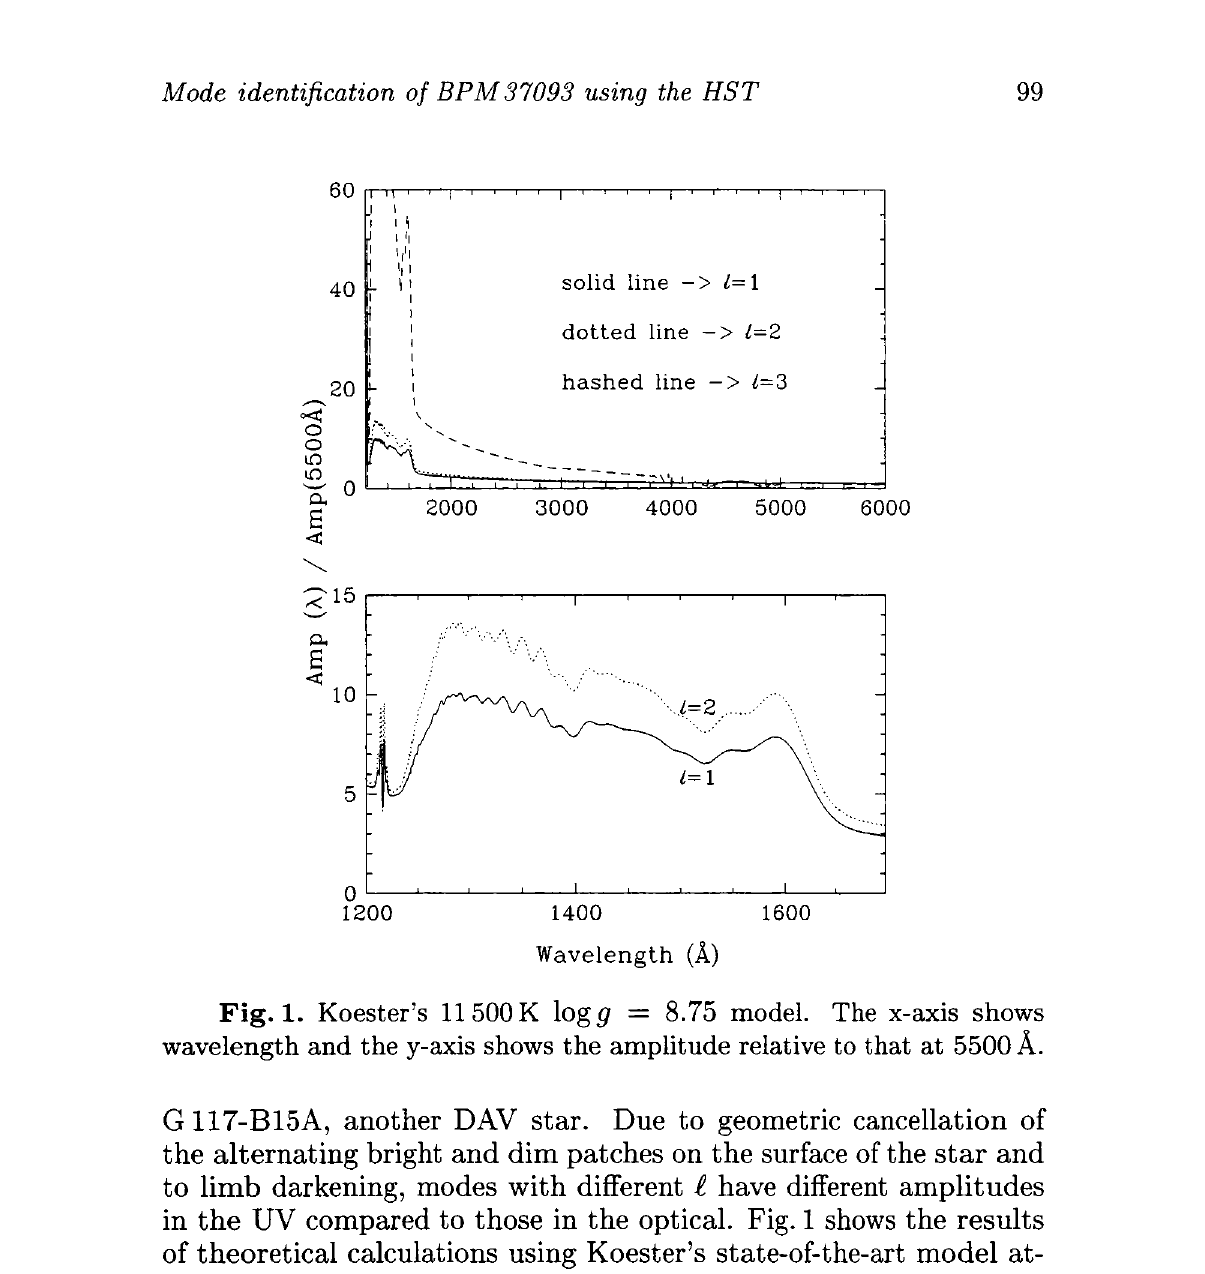
Fig. 1. Koester's 11 500 K logg = 8.75 model. The x-axis shows wavelength and the y -axis shows the amplitude relative to that at 5500 A. G117-B15A, another DAV